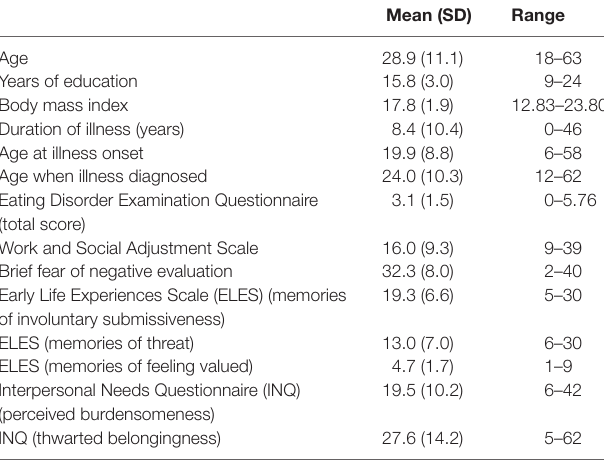
TaBle 1 | Demographic, clinical and social functioning